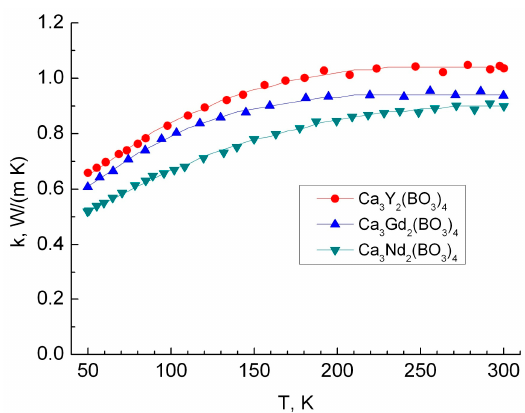
Figure 4. Temperature dependence of the thermal conductivity k (T) for Ca 3 RE 2 (BO 3 ) 4 (RE = Y, Gd, Nd) crystals along the c axis.